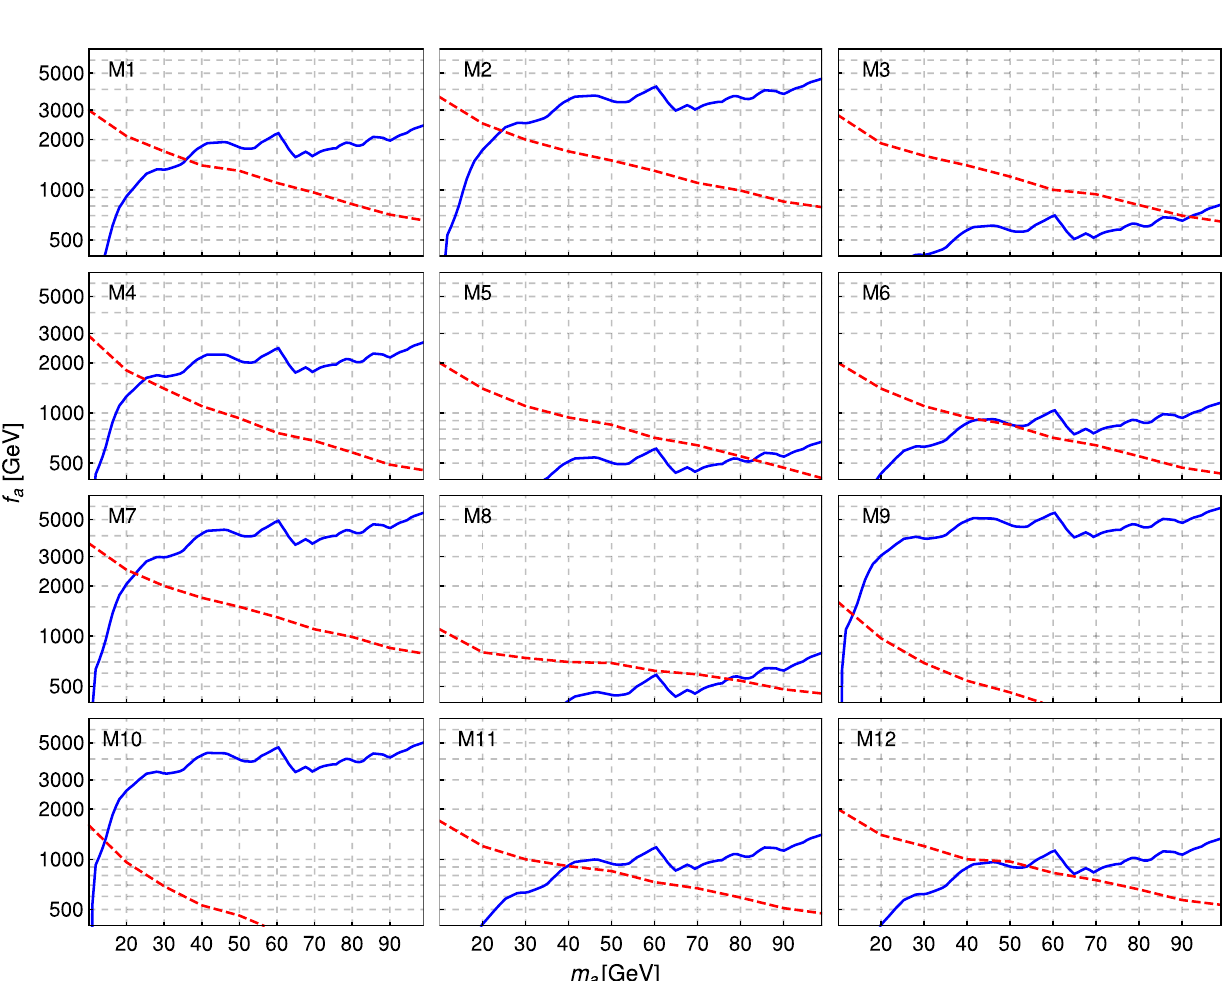
√ Fig. 8 Projected bounds on f a from a boosted di-tau search with s = 13 TeV after an integrated Luminosity of 300 fb − 1 (red dashed, from Fig. √ s = 14 TeV after an integrated Luminosity of 300 fb − 1 (blue solid, projections following Ref. 2) and from a boosted di-photon search with